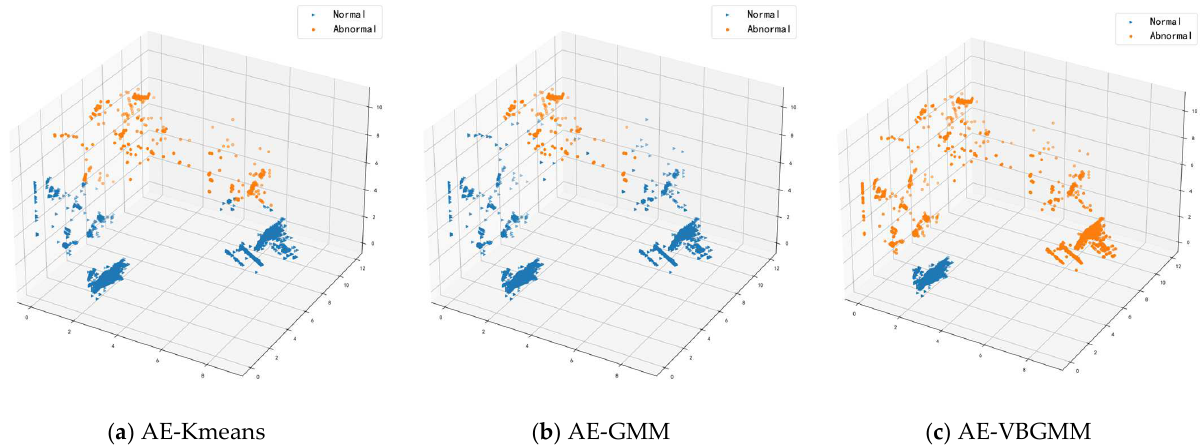
Figure 5. Abnormality detection of normal data benign and abnormal data ackflooding using three methods, AE-Kmeans, AE-GMM, and AE-VBGMM, where orange represents abnormal data, and blue represents normal data.